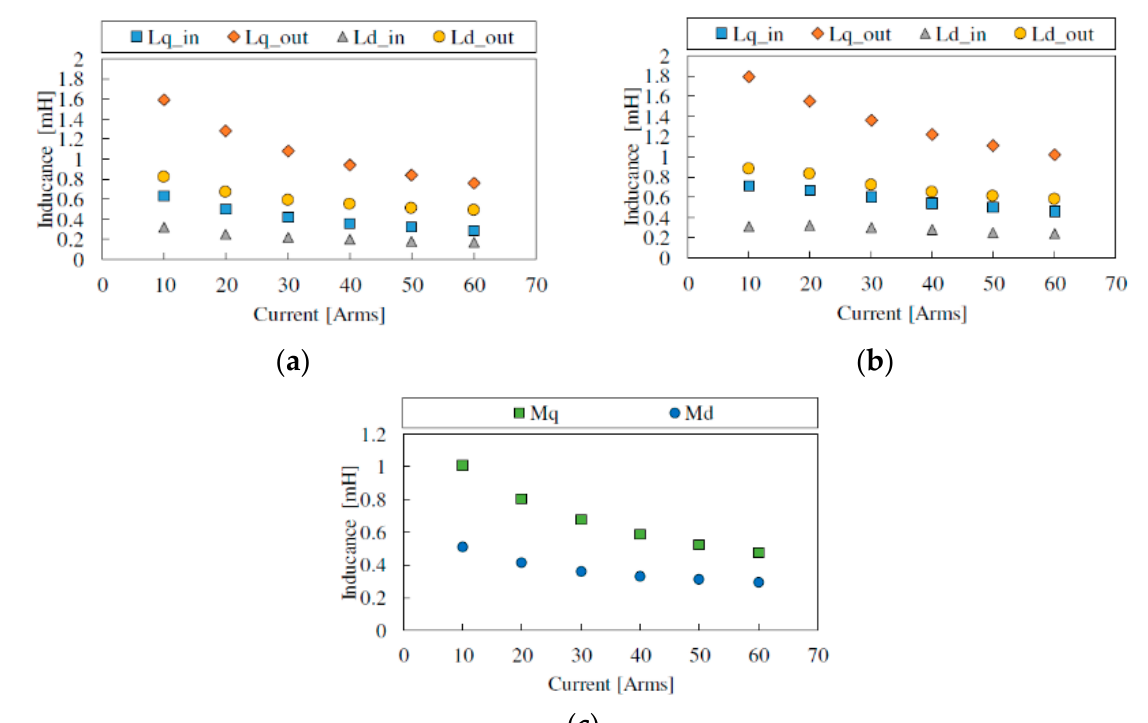
World Electr. Veh. J. 2021 , 12 , x FOR PEER REVIEW Figure 9. ( a ) Inductances at mode A, ( b ) Inductances at mode B, C, ( c ) Mutual inductances.